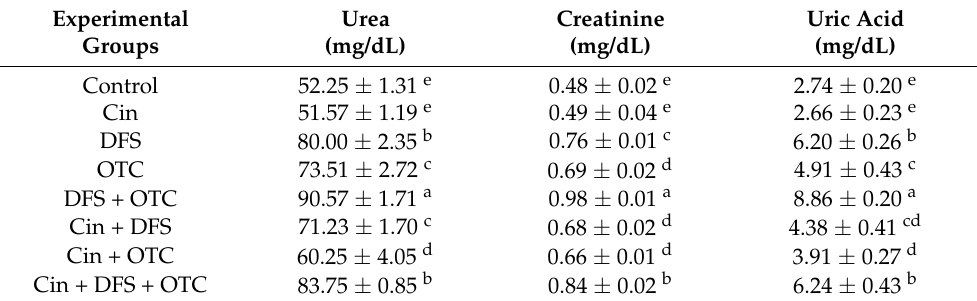
Table 3. Serum levels of renal function biomarkers in the control and experimental groups.